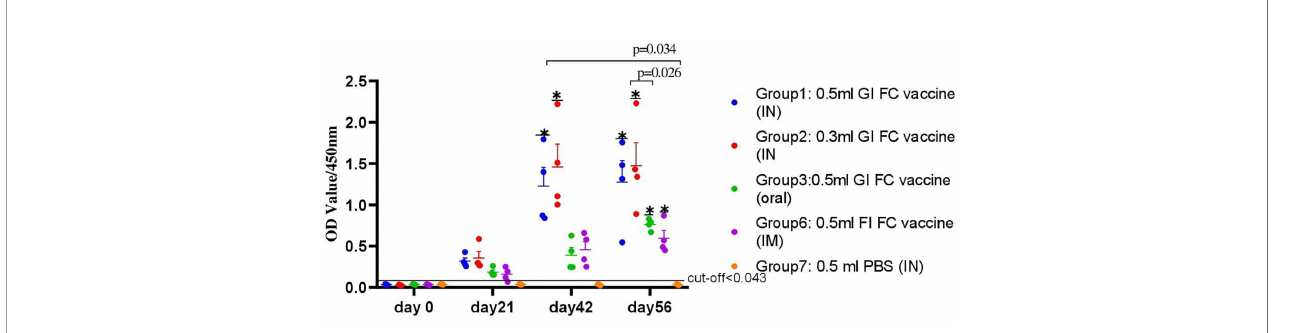
FIGURE 5 | A total of 80 chickens were chosen from all groups. Tracheal (G-1, G-2, G-4, and G-7) and crop lavage (G-3) was taken from four chickens from each group that were euthanized on different period of interval: day 0, 21, 42, and 56 of the experiment; thus, a total of 16 chickens from each group were euthanized for this purpose. Trachea and crop were washed by glycine buffer and analyzed for the presence of IgA. The data were presented as individual values for each experimental group. Mean and standard error of means are indicated in lines and error bars. Asterisk (*) represents the signi fi cant differentiation of antibody IgA level compared to the non-vaccinated control group (*p